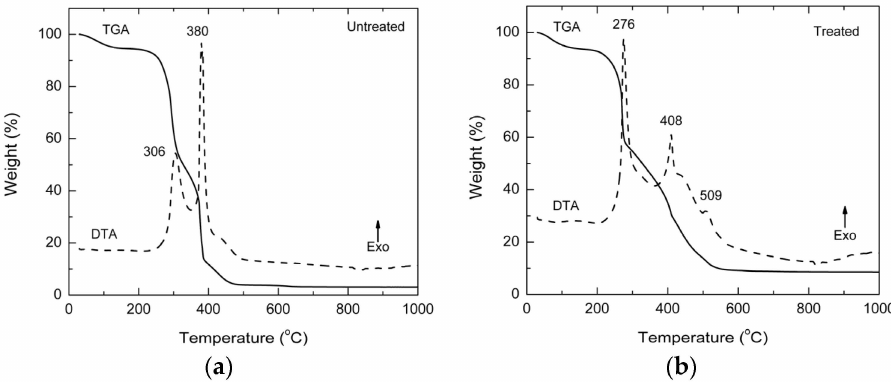
Figure 2. TGA/DTA curves of castor oil cake samples: ( a ) without treatment (MST); and ( b ) with solvent extraction treatment